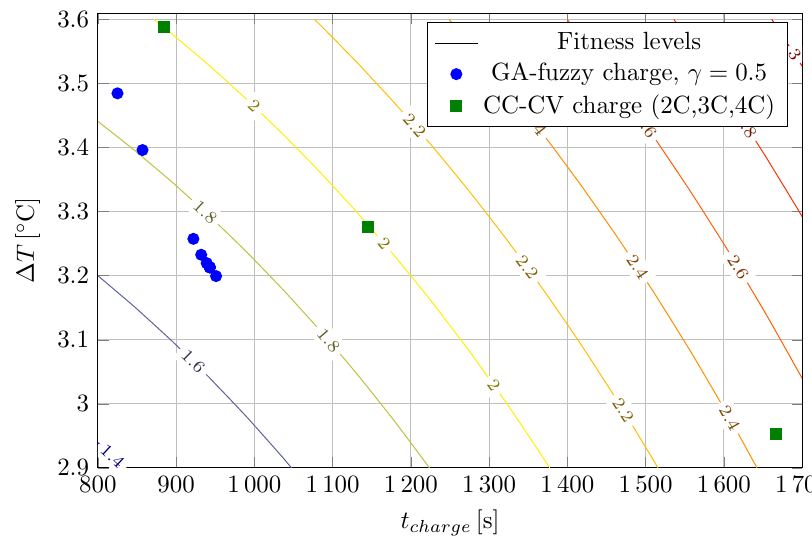
∆ T plane for γ = 0.5. −